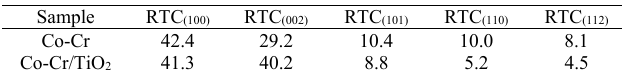
Table 2. Relative texture coefficient values for different diffraction lines